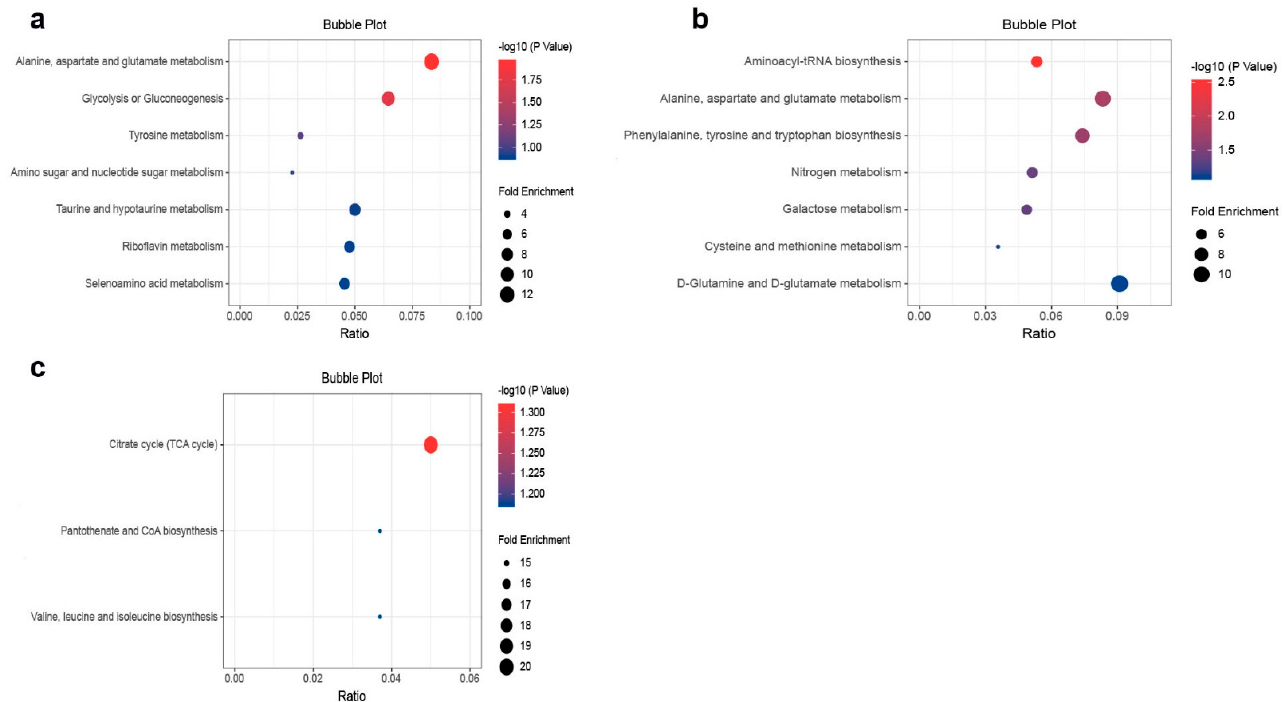
Figure 6. Koto Encyclopedia of Genes and Genomes (KEGG) pathway classification of comparison groups. ( a ) Comparison groups of CK vs. H1, ( b ) comparison groups of CK vs. H3, ( c ) comparison groups of H1 vs. H3. CK, control group; H1, group with heat stress treatment for 1 d; H3, group with heat stress treatment for 3 d.